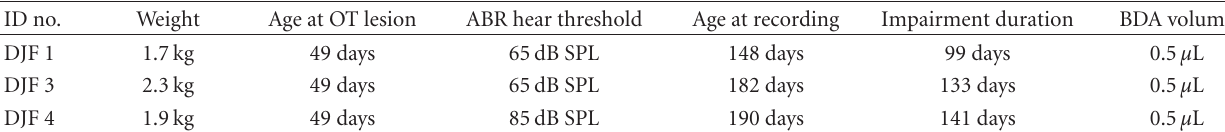
Table 1: Hearing and age statistics for the ferrets with early hearing loss induced by ototoxic lesion (OT); all animals were male. The age of hearing onset in ferrets is ∼ 32 days postnatally, and auditory critical period closure for A1 is 80 days [16].